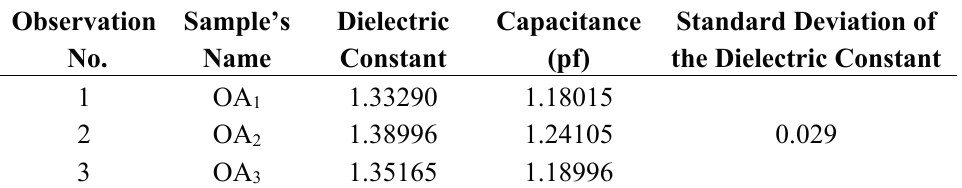
Figure 8. Performance of proposed IDC taste sensing: ( a ) amplitude across the IDC taste sensing element at different concentrations of HCl; and ( b ) change in the phase shift. Table 2. Statistical data of the proposed IDC taste sensor array of the three observations of three samples of OA-containing sensing